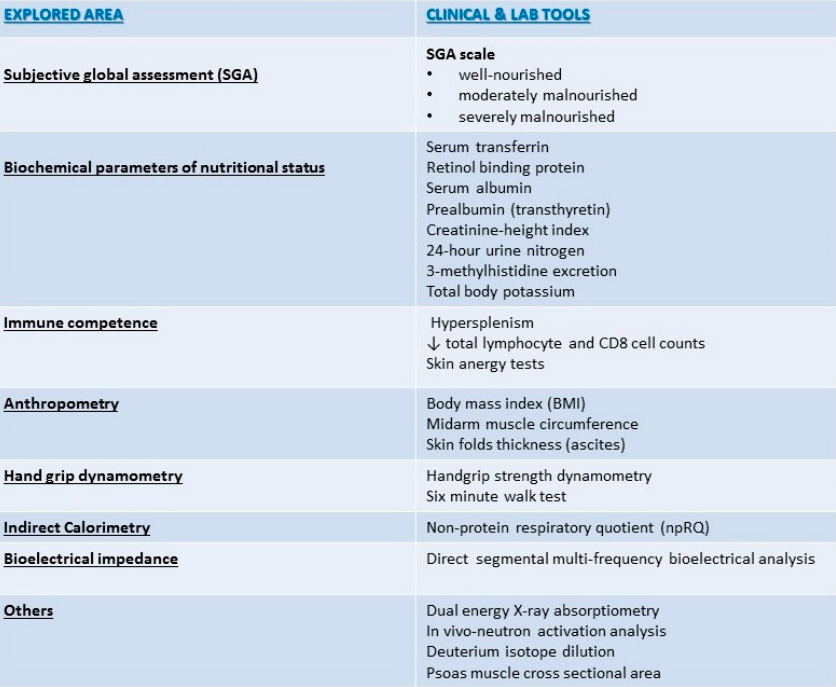
Figure 2. Assessment of nutritional status in End Stage Liver Disease Patients.